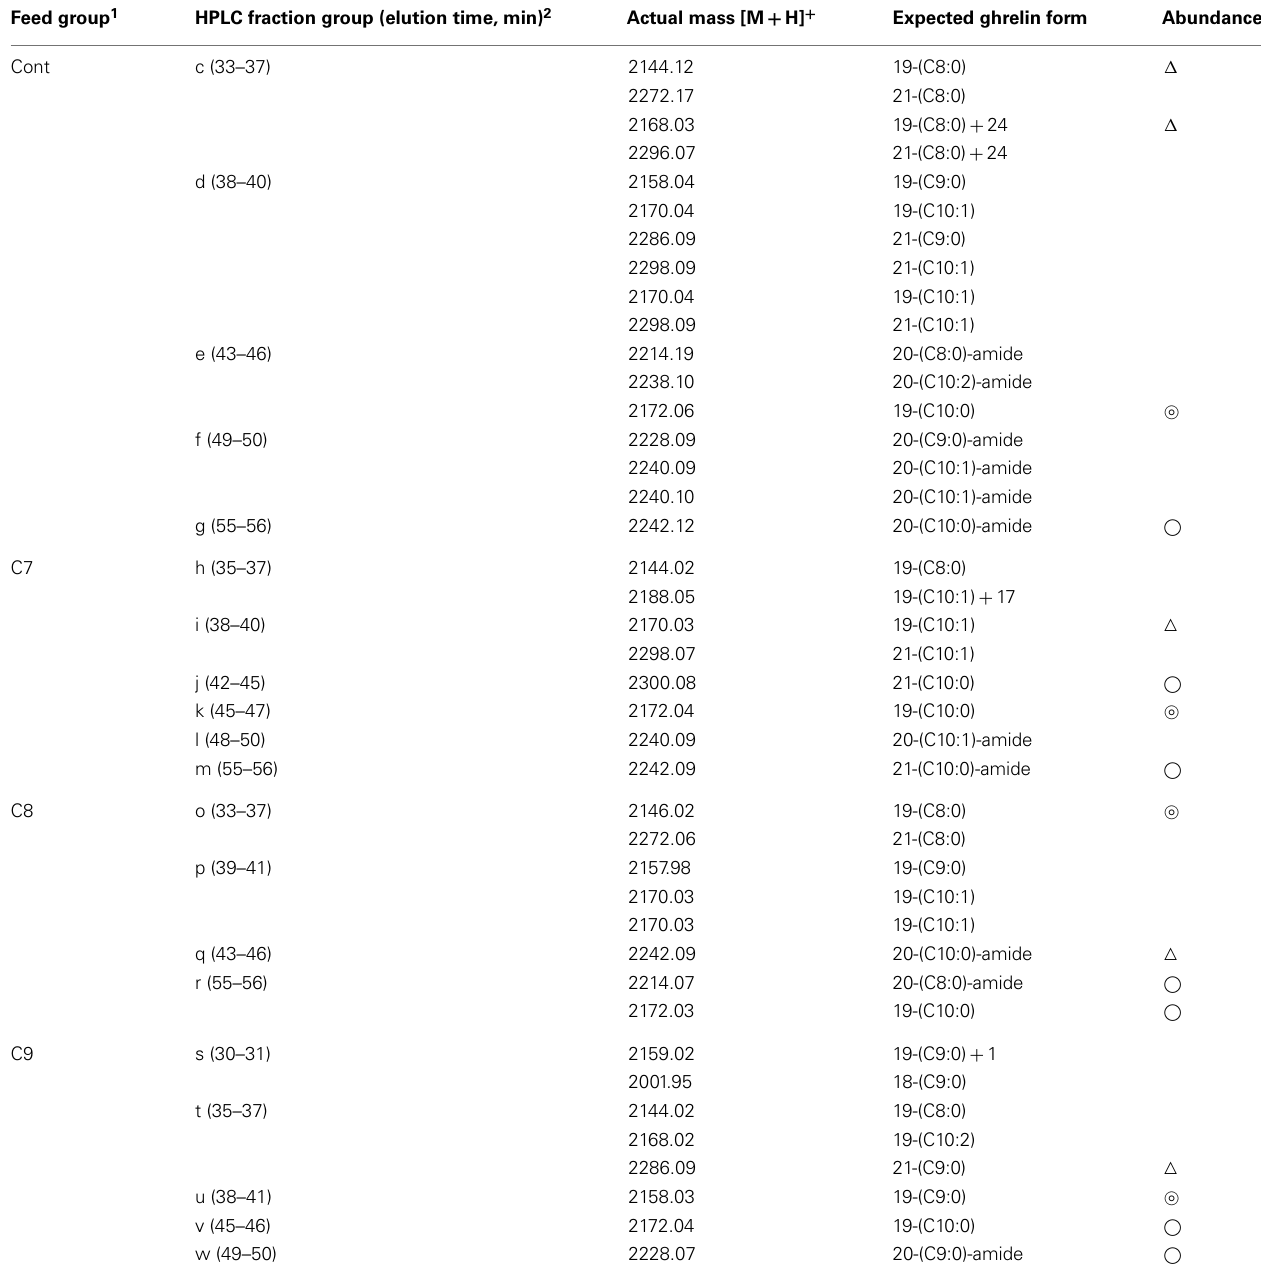
Table 1 | Masses and expected molecular forms of ghrelins purified from barfin flounder stomach extracts by carboxymethyl ion-exchange HPLC. Feed group